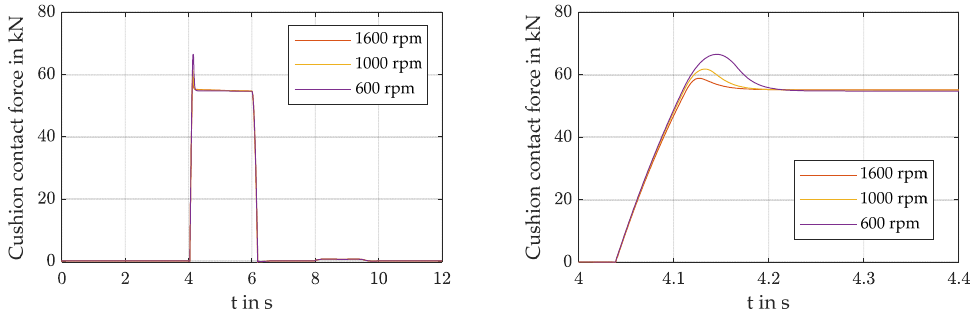
Figure 8. Cushion contact force for different motor speeds (simulation).